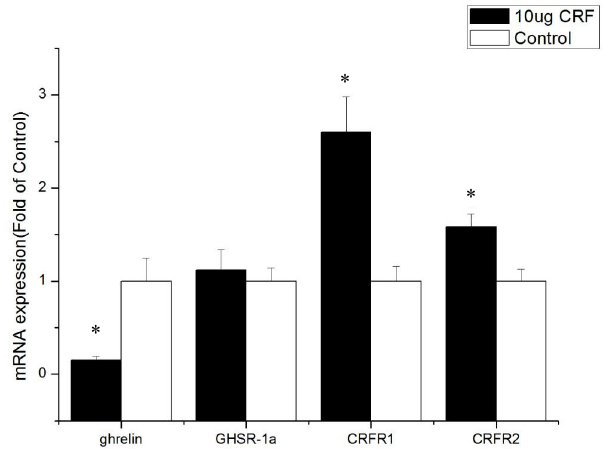
Figure 5. Effect of intracerebroventricular injection of corticotropin-releasing factor (CRF) on genes in the ileum of broiler chickens. Control = control group (basal diet); 10 μg = 10 μg/kg body weight. n = 8. * p<0.05 (compared with control).